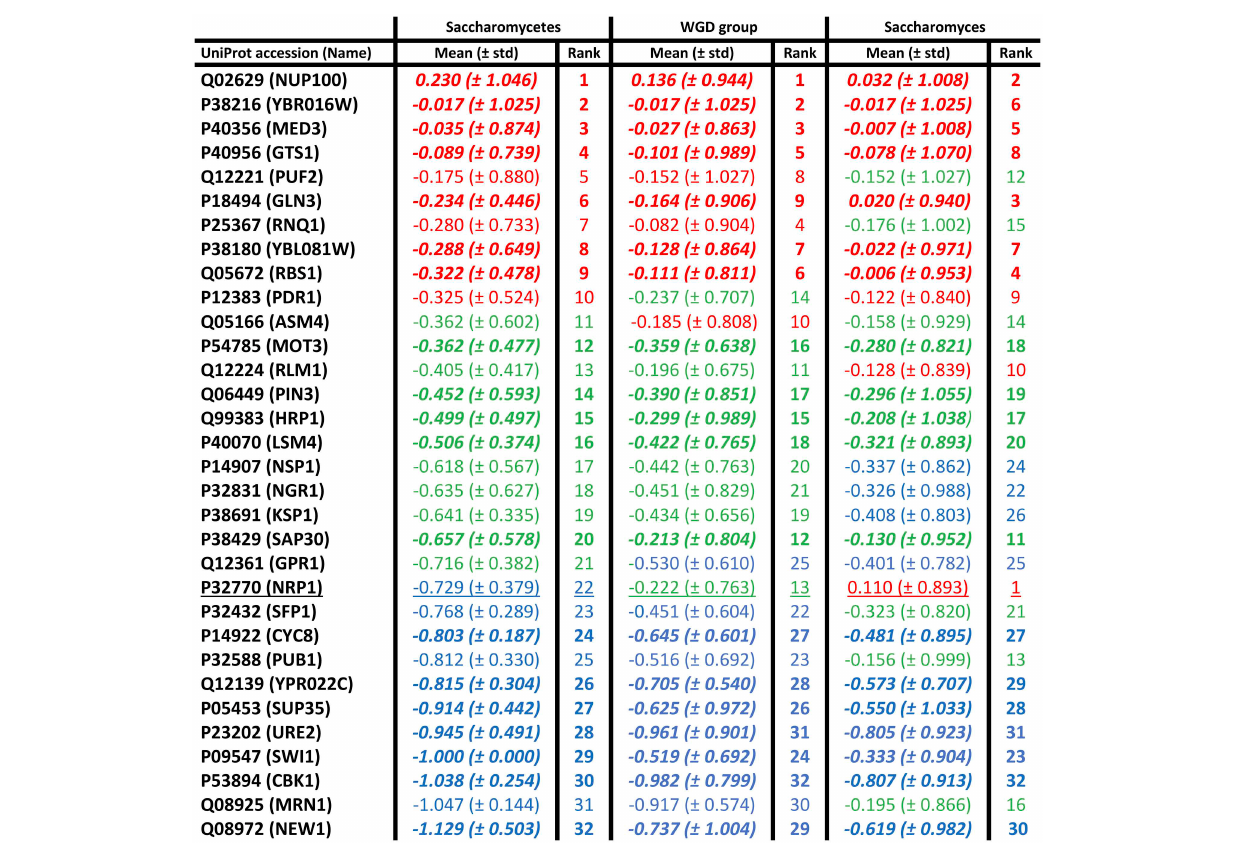
Frontiers in Molecular Biosciences |